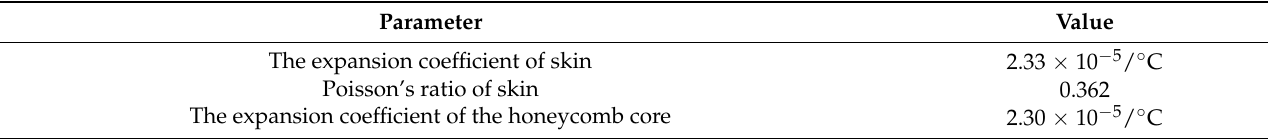
Table 9. Modified finite element model parameters.